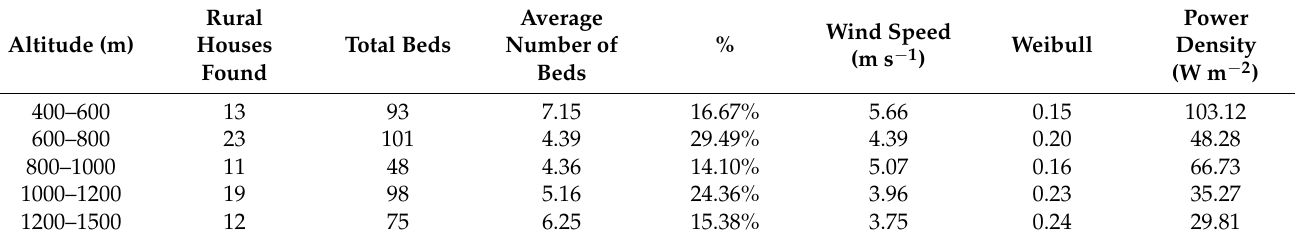
Table 1. Data by altitude of solar and wind